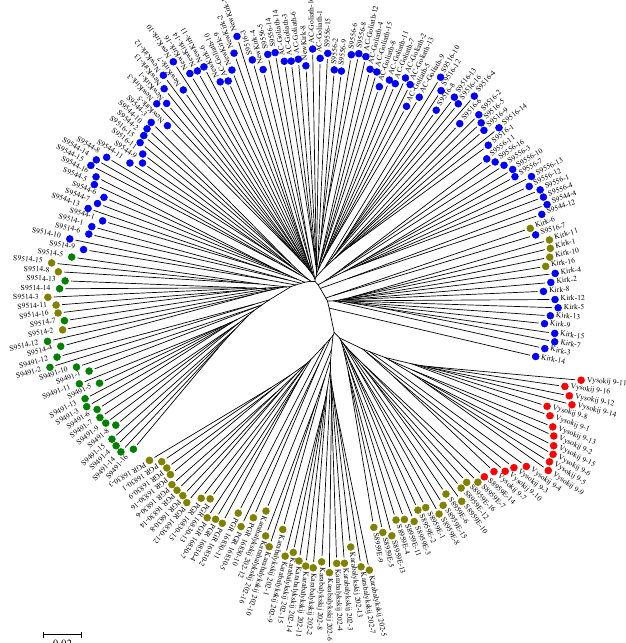
Figure 3. Genetic relationship of 192 genotypes of the 12 crested wheatgrass lines as revealed by neighbor-joining clustering with the 45,507 SNP markers. Each genotype is numbered after its line label. Each node for a genotype is represented with colored circle followed by genotype name. Red, green, blue, and yellow represent plants in Clusters 1, 2, 3, and 4, inferred from the STRUCTURE analysis (Figure 2A), respectively.